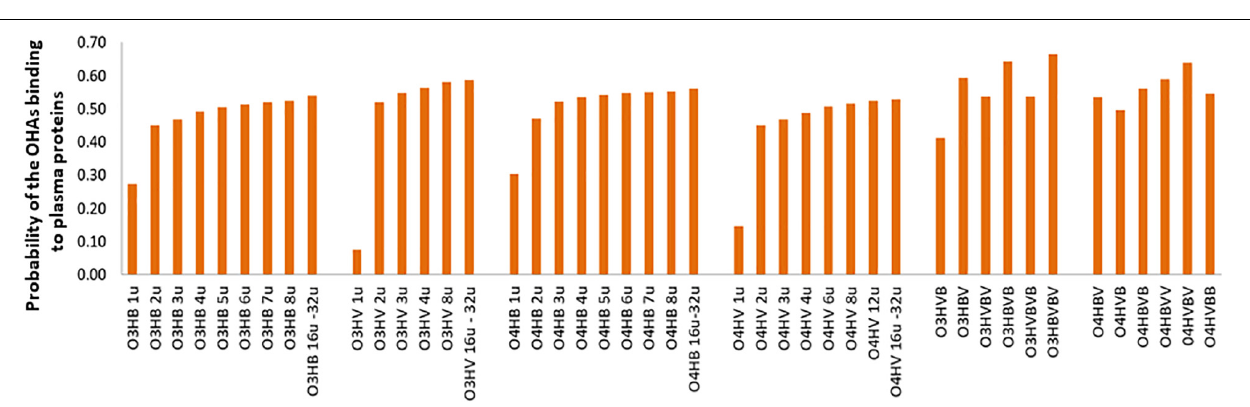
FIGURE 3 | Probabilities of the OHAs binding to plasma proteins (PPB) of low molecular weight oligo-hydroxyalkanoates calculated by admetSAR2.0. Abbreviations are used as explained in Figure 2